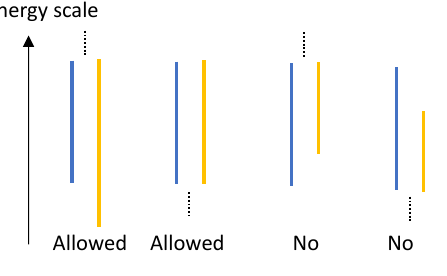
Figure 11 . Examples of possible and impossible symmetry breaking patterns constrained by the 3- group symmetry. The blue (left) segment is the energy scale where the 2-form symmetry is broken, while the orange (right) segment is the energy scale where the 0-form or 1-form symmetry is broken. Namely, when the 2-form symmetry is broken the 0-form or 1-form symmetry must also be broken, but not vice